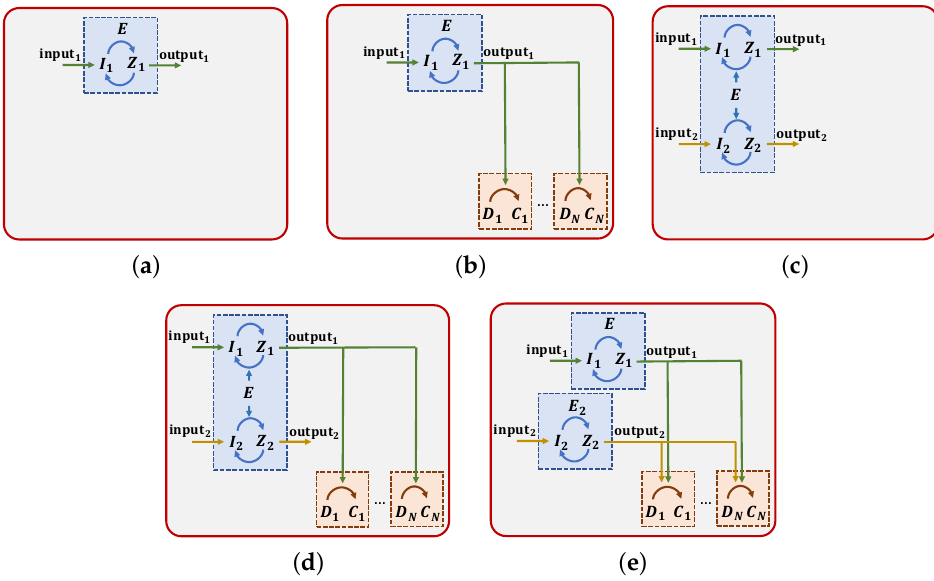
Figure 3. Diagrams of the signaling systems analyzed in the paper: ( a ) isolated SISO, ( b ) SISO with 𝑁 downstream targets, ( c ) isolated MIMO, ( d ) MIMO with 𝑁 downstream targets, ( e ) two isolated SISO with